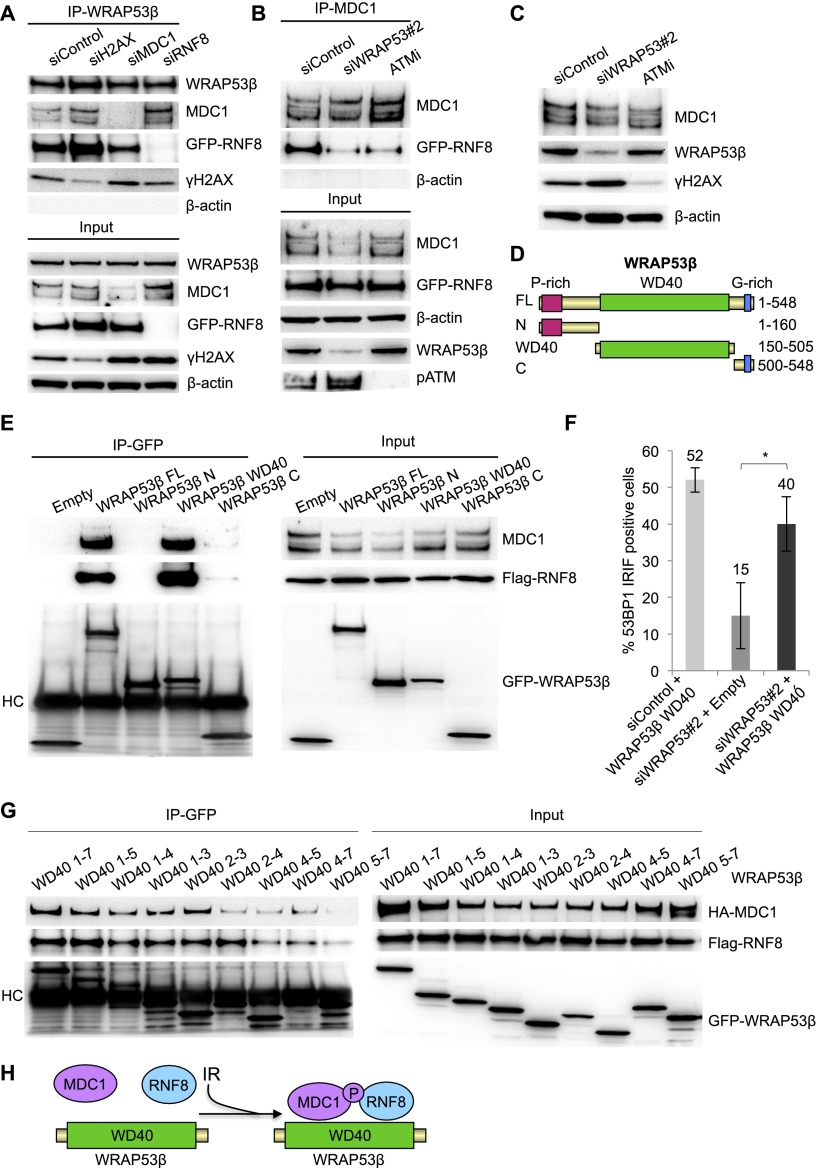
WRAP53β facilitates MDC1–RNF8 interaction through its WD40 domain. (A) U2OS cells were treated with the siRNAs indicated for 48 h and with GFP-RNF8 for 24 h (all samples), irradiated with 6 Gy, and, 30-min later, subjected to immunoprecipitation of WRAP53β followed by immunoblotting of WRAP53β, MDC1, RNF8, γH2AX, and β-actin. (B) Immunoprecipitation of MDC1 in irradiated (6 Gy, 15-min recovery) U2OS cells treated with the siRNA indicated for 48 h or ATM inhibitor (ATMi) for 24 h. All samples were transfected with GFP-RNF8 for 16 h. (C) U2OS cells were treated with the siRNAs indicated for 48 h or ATM inhibitor for 16 h, irradiated with 6 Gy, allowed to recover for 15 min, and then subjected to Western blotting of MDC1, WRAP53β, γH2AX, and β-actin. (D) Schematic illustration of EGFP-tagged deletion constructs of WRAP53β. (E) U2OS cells were transiently transfected with the indicated EGFP-WRAP53β plasmids and Flag-RNF8 for 16 h, irradiated, and subjected to GFP immunoprecipitation followed by immunoblotting for MDC1, Flag-RNF8, and GFP-WRAP53β. (HC) Heavy chain of the antibody. (F) U2OS cells were transfected with siControl or siWRAP53#2 oligonucleotides for 8 h followed by transfection of EGFP-Empty or EGFP-WRAP53β WD40 (1–7) for 16 h, exposed to IR (6 Gy), and, after 1 h, immunostained for 53BP1 followed by quantification of the results. The graph in A shows the percentage of 100 GFP transfected cells in each experiment whose nuclei were 53BP1-positive. The error bars depict the SEM. n = 3; (*) P < 0.05, as determined by Student’s t-test. (G) U2OS cells were transiently transfected with the indicated EGFP-WRAP53β plasmids, HA-MDC1, and Flag-RNF8 for 16 h; irradiated; and subjected to immunoprecipitation of GFP followed by immunoblotting for HA-MDC1, Flag-RNF8, and GFP-WRAP53β. (H) Schematic illustration of how WRAP53β scaffolds the MDC1–RNF8 complex. Upon DNA damage, WRAP53β binds MDC1 and RNF8 simultaneously via its WD40 domain and facilitates their interaction.